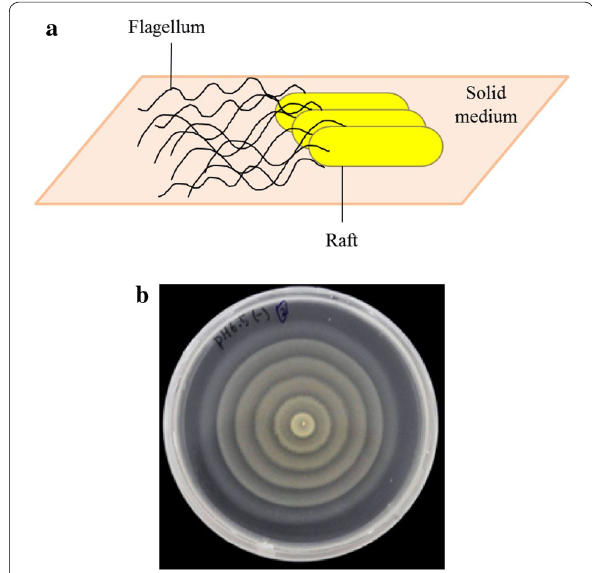
Fig. 2 a Ultrastructure model of swarming phenomenon drive by side‑by‑side multicellular raft. b Bull’s eye pattern of Proteus hauseri ZMd44 in LB plate